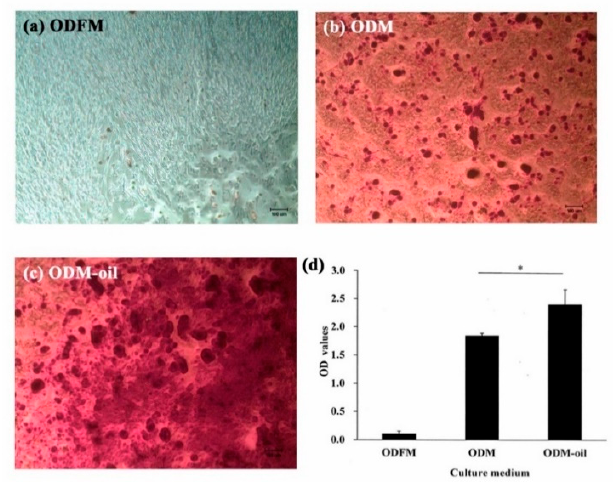
Figure 5. Odontogenic differentiation capacities of DPSCs as assessed by Alizarin red S staining after 14-day culture period. ( a ) No mineralized nodule deposition is observed when the DPSCs are cultured in general medium. ( b ) Following odontogenic medium induction, observable mineralized nodule deposition occurs. ( c ) Following co-culturing with odontogenic medium and S. mukorossi seed oil, the DPSCs secrete more abundant mineralized nodules. ( d ) Quantification of the Alizarin red S staining results shows a significant difference between the ODM and ODM-oil groups (* p < 0.05). (Note ODFM: odontogenesis induction-free medium; ODM: odontogenesis induction medium; and ODM-oil: odontogenesis induction medium with S. mukorossi seed oil.). Scale bar for a , b and c denote 100 µm.